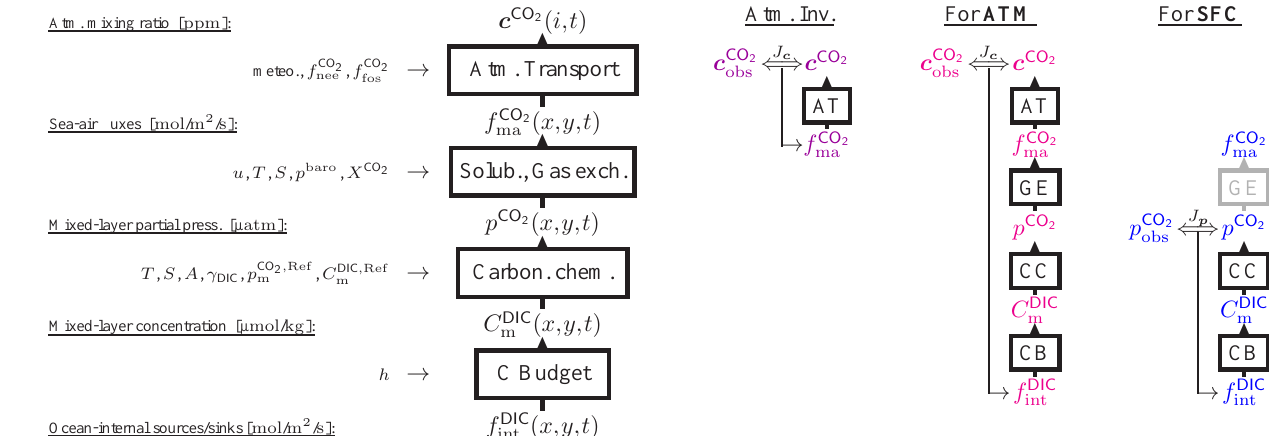
Fig. 2. Illustration of the inverse procedure (three modi). Boxes de- note the process parameterizations from Figure 1, causally linking quantities from bottom to top. Double arrows symbolize the match- ing between observed and modelled quantities, as gauged by a cost function J (Appendix A2). Thin arrows indicate the adjustments of the respective unknowns done to minimize the model-data mis- match. Left: Pure atmospheric transport inversion not used here but given for reference: The sea-air fluxes f CO 2 ma are adjusted to match atmospheric mixing ratios (terrestrial Net Ecosystem Exchange is adjusted as well but omitted from this schematic for clarity). Mid- dle: In case ATM , ocean-internal sources/sinks f DIC int are adjusted instead of sea-air fluxes to match atmospheric CO 2 mixing ratios (again Net Ecosystem Exchange is further adjusted). Right: In case SFC , ocean-internal sources/sinks are adjusted to match the surface-ocean CO 2 partial pressure observations. Sea-air fluxes are then calculated from the estimated partial pressure field.